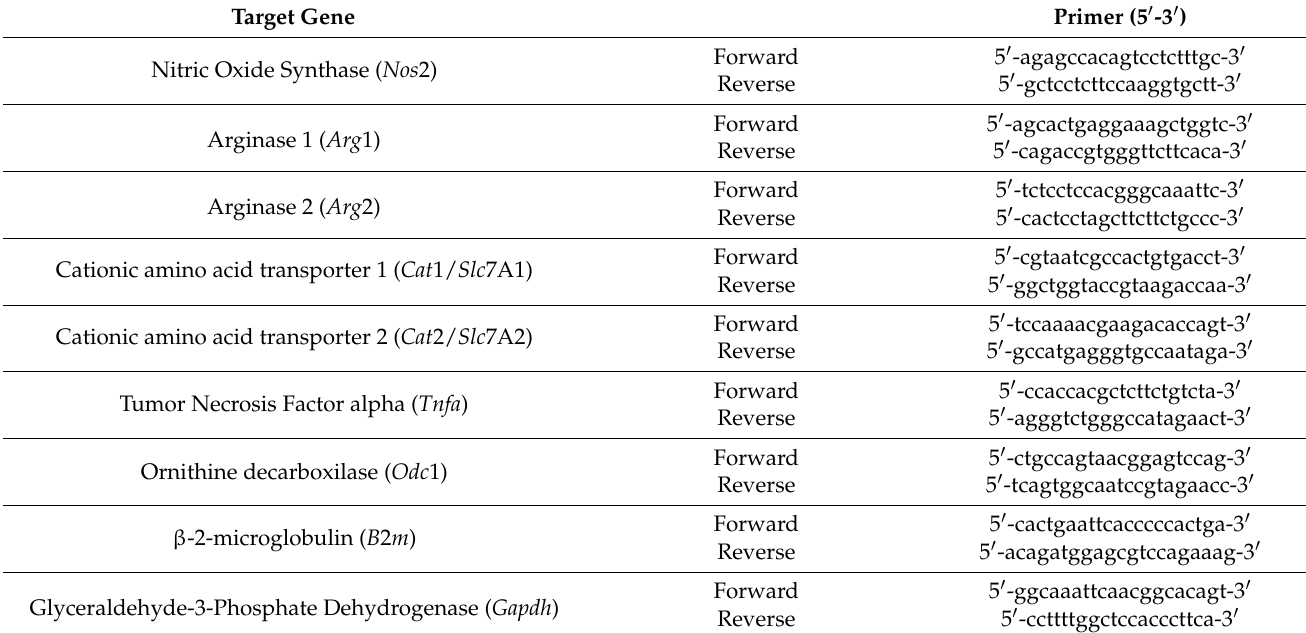
Table 1. Primer sequences for